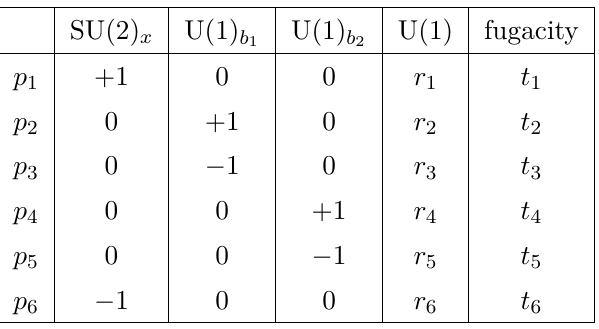
Table 27 . Global symmetry charges on the extremal brick matchings p i of Model